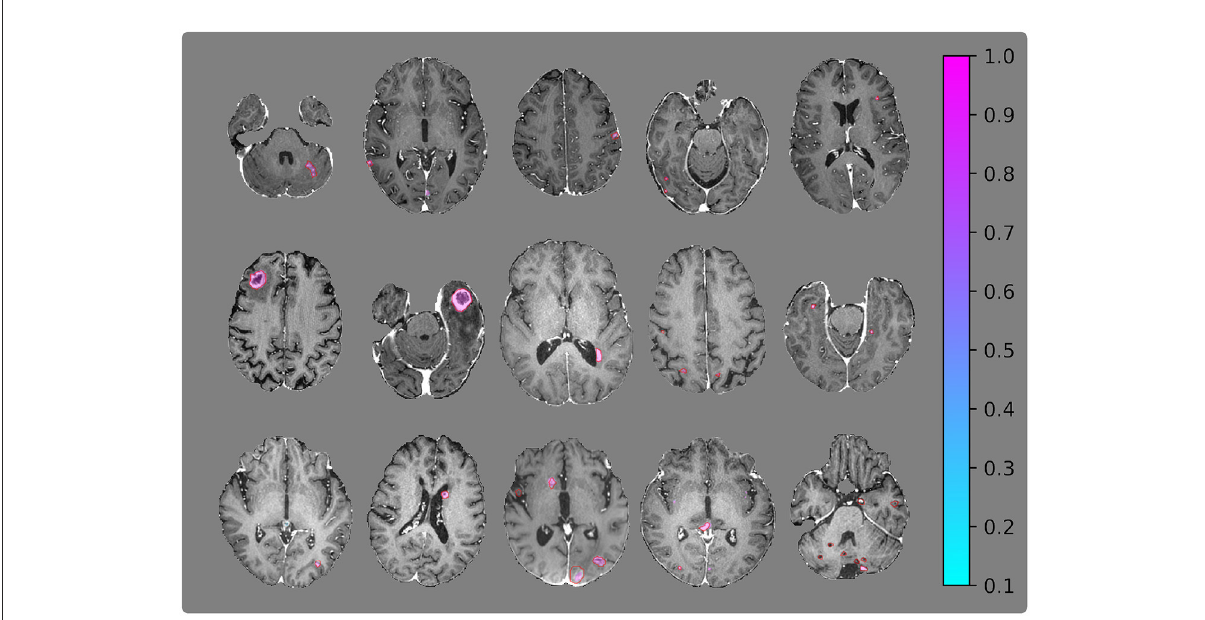
FIGURE6 Visualization of segmentation examples from the Stanford cohort with the ground truth annotation (red regions of interests) and the segmentation probability map from the 2.5D network. The (bottom right) image slice belongs to the patient with 153 metastases and is one of the worst cases from the test